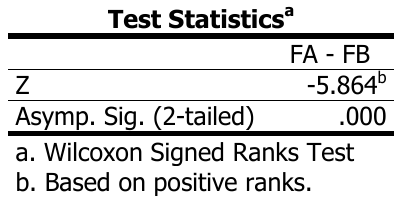
Table 12. Statistical Test of the Effect of Fantasy Motivation after The Inauguration of the